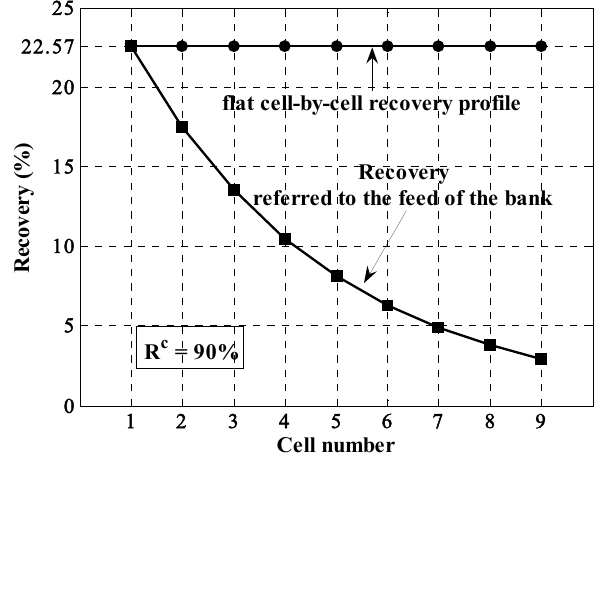
Figure 8. Optimal flat cell-by-cell recovery profile for a target bank recovery of 90% = 22.57%; and recovery profile based on bank giving R i